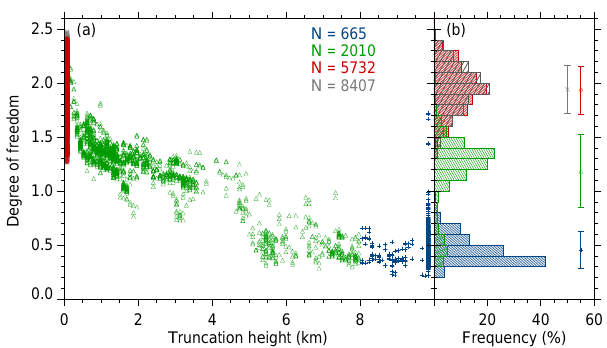
Figure 18. (a) Degree of freedom as a function of truncation height for different situations introduced in Table 2. (b) Frequency distri- bution of the degree of freedom. The symbols and error bars cor- respond to the related mean and standard deviation, respectively. The numbers indicate the sample size of the considered profiles; full height (blue), truncated (green), no lidar (red) and OEM MWR (grey).